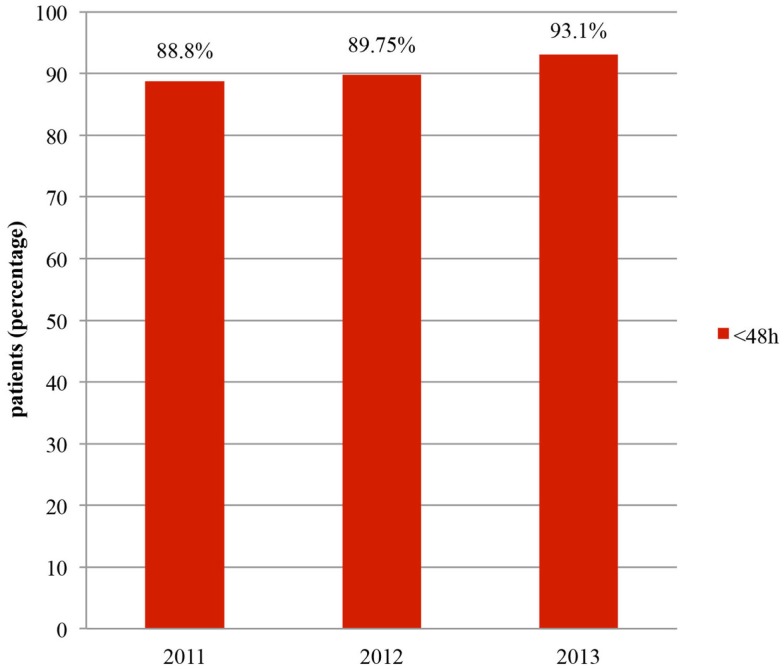
Surgery within 48 h.